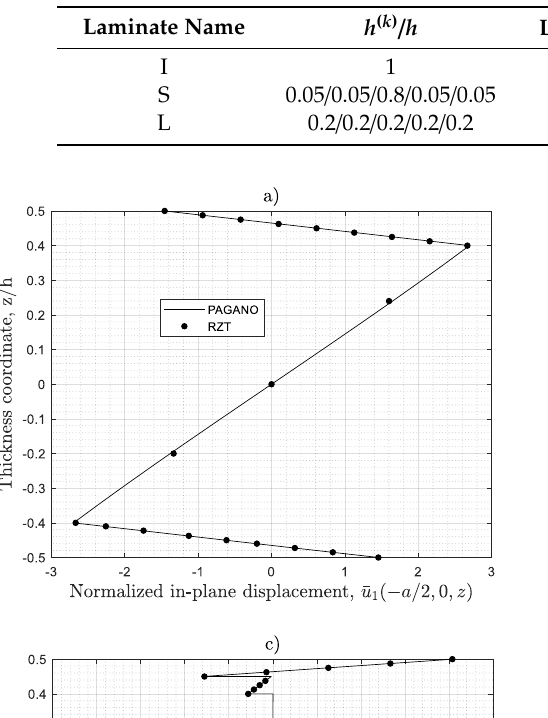
Table 3. Laminate composites and sandwich plates.